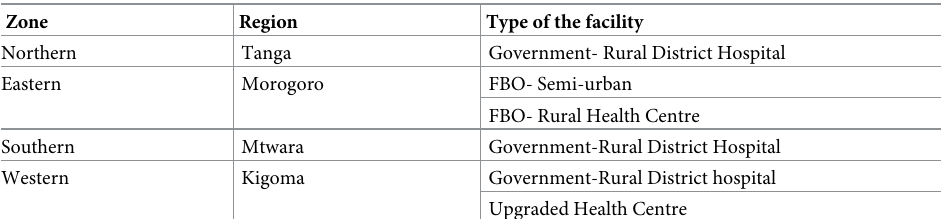
Table 1. Zones, region and type of healthcare facilities involved in the